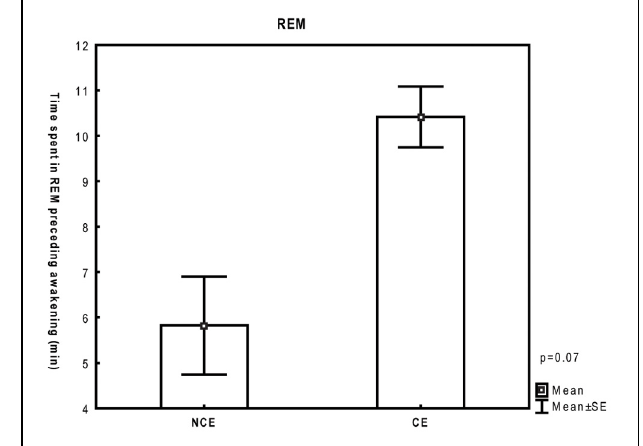
FIGURE 4 | Proportionof conscious experiences (CE), conscious experiences without recall (CEWR) and no conscious experiences (NCE) across stages.